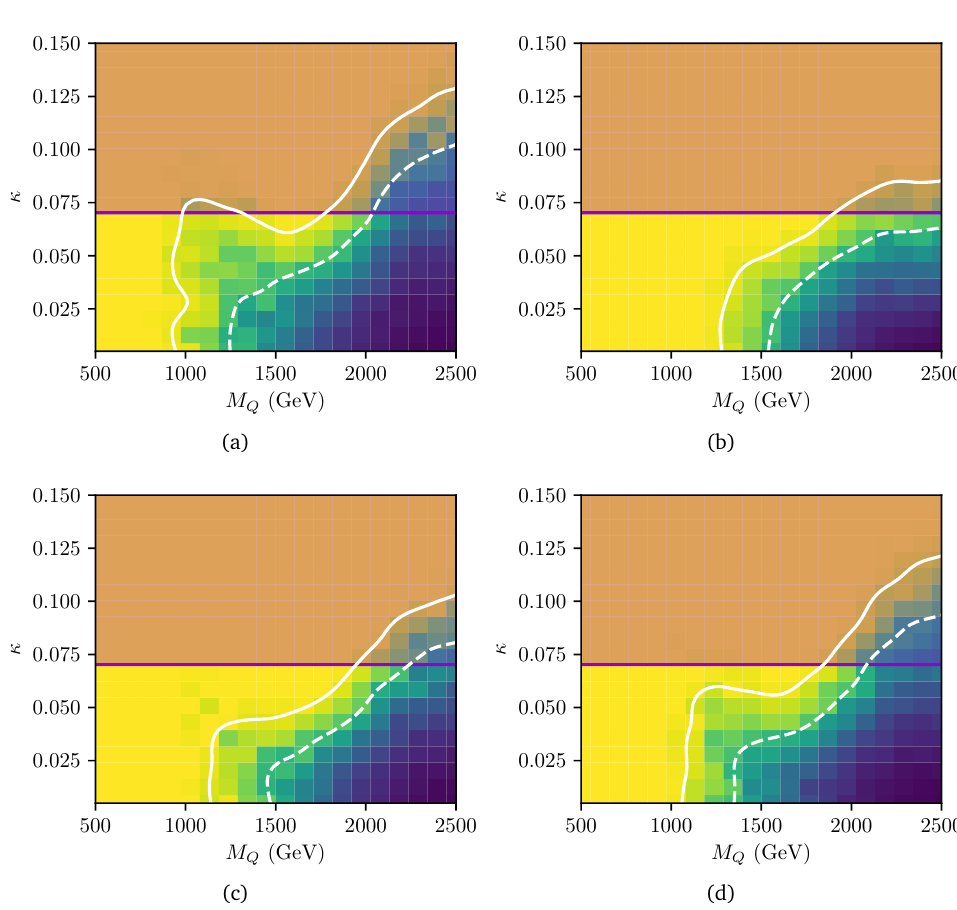
Figure 20: Sensitivity of LHC measurements to VLQ production in the κ vs VLQ mass plane, where κ is the coupling to first-generation SM quarks. All VLQ ( B , T , X , Y ) masses are set to be degenerate. The green and yellow regions are disfavoured at 68% CL and 95% CL respectively, with the dashed and solid white contours delineating the boundaries. The VLQ branching fractions to W : Z : H are (a) 0:0:1 (b)